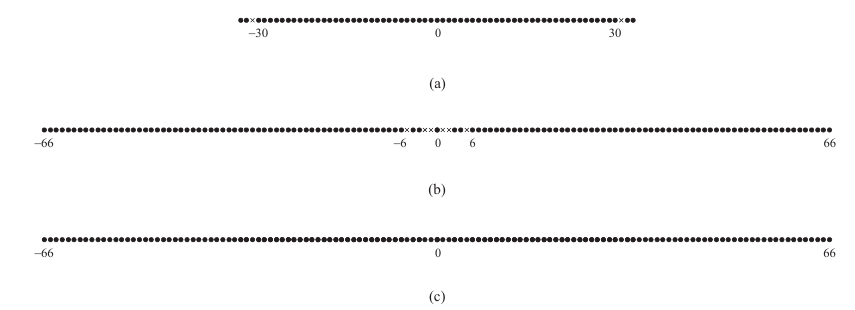
Figure 5. The consisting sets of the diff–sum coarray for the DsCAMpS with ( M , N , P 2 ) = ( 4,3,3 ) : ( a ) the difference set S dif f ; ( b ) the total sum set S sum ; and ( c ) the diff–sum set S ds .